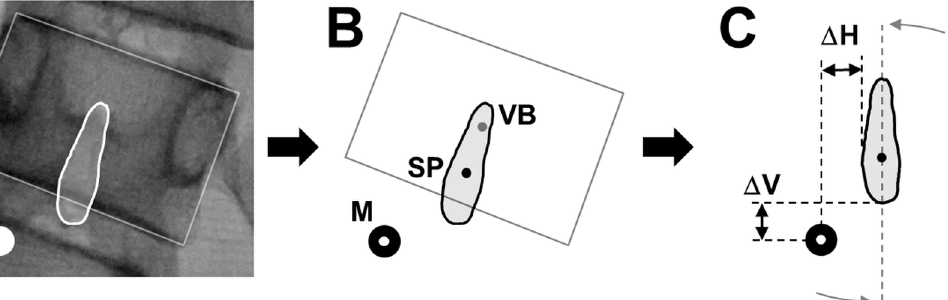
Fig 1. Illustration of the data extraction procedures from the posterior-anterior radiographic images. A) Identification of the shapes of the marker, vertebral body and spinous process, B) calculation of the centers of area (CoA) of the marker (M), vertebral body (VB) and spinous process (SP) and C) calculation of the horizontal ( Δ H) and vertical ( Δ V) distance between the marker ’ s CoA and the spinous process